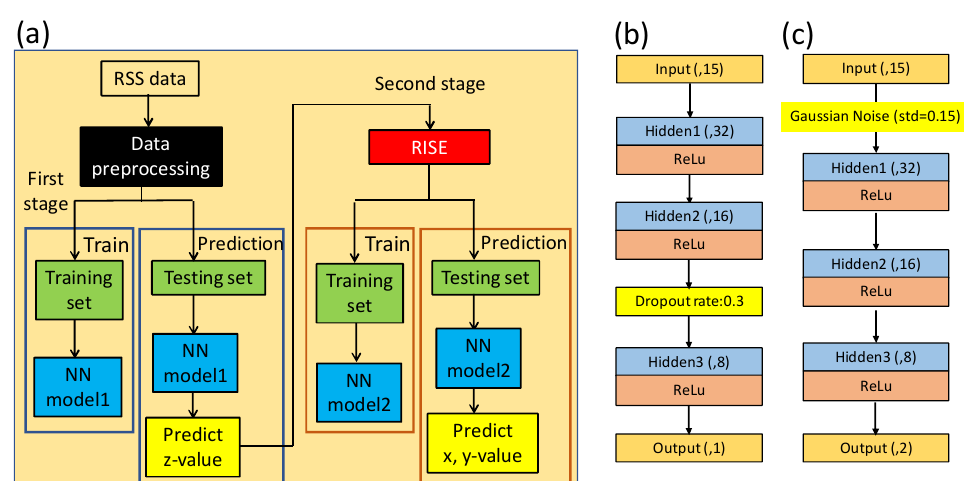
Figure 5. ( a ) Flow chart of the two stage NN (TSNN) model. ( b , c ) Structures of NN models.